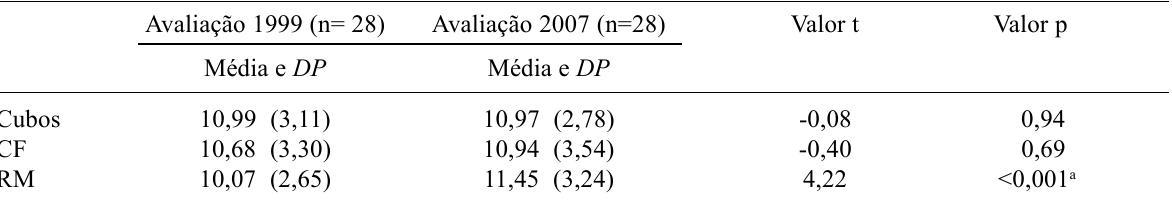
Nota . Legenda: CF = Completar Figuras e RM= Raciocínio Matricial. a Resultados significativos ( p <